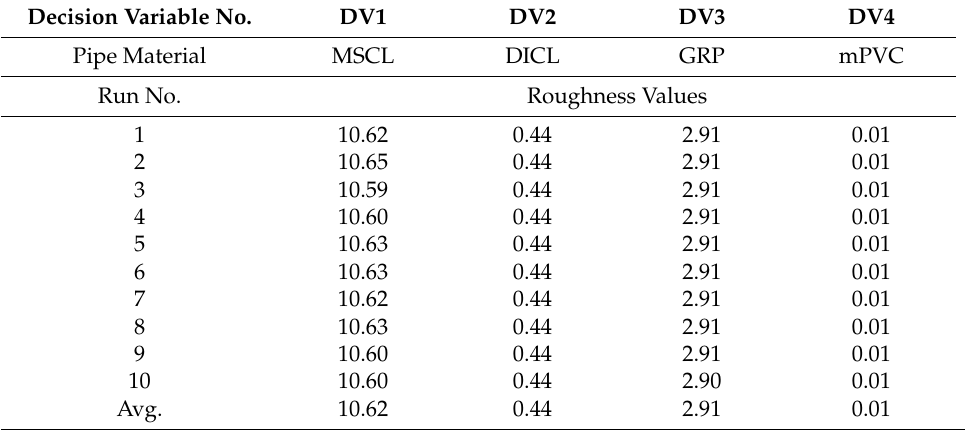
Table 4. Pipe roughness values obtained from Formulation 2 (4 DVs) with the SLSQP method. Decision Variable